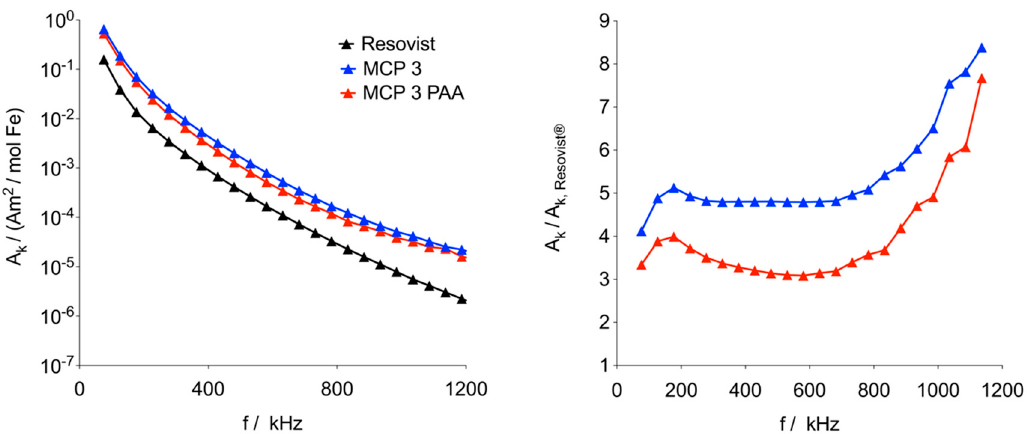
Figure 4. Left: magnetic particle spectroscopy (MPS) data of MCP 3 in aqueous dispersion (blue) and polyacrylamide (PAA) gel (red) in comparison with Resovist ® (black) at 10 mT and 25 kHz. Data are plotted as magnetic moment (normalized to iron content) versus frequency. Right: The ratio of amplitudes of MCP 3 and Resovist ® in aqueous dispersion (blue) and in the PAA gel matrix (red). In both cases, only odd harmonics are shown, and lines were added to guide the eye.